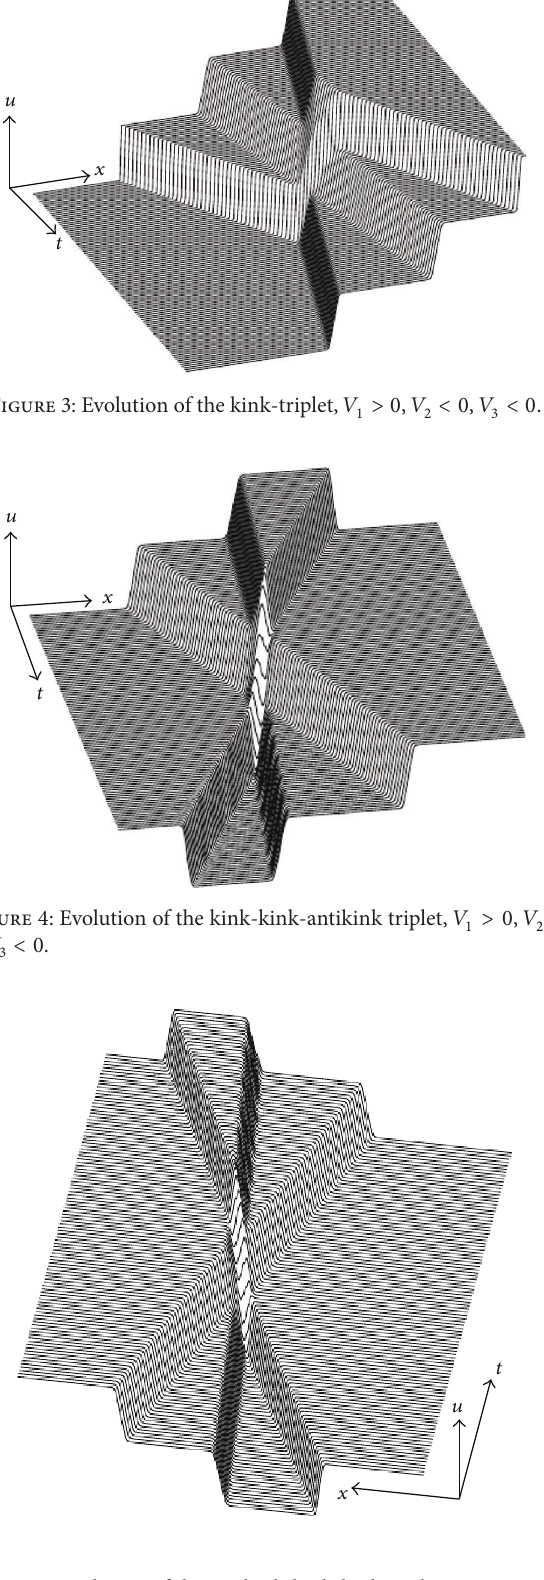
Figure 8: Evolution of four waves for the nonlinearity (43), 𝑉 1 > 0 ,